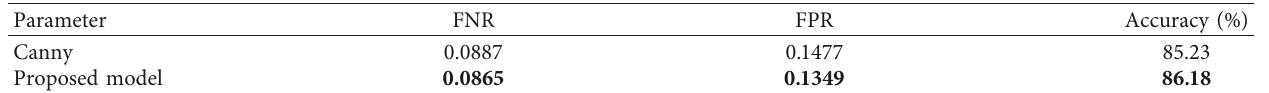
Table 2: Comparison of average segmentation assessment